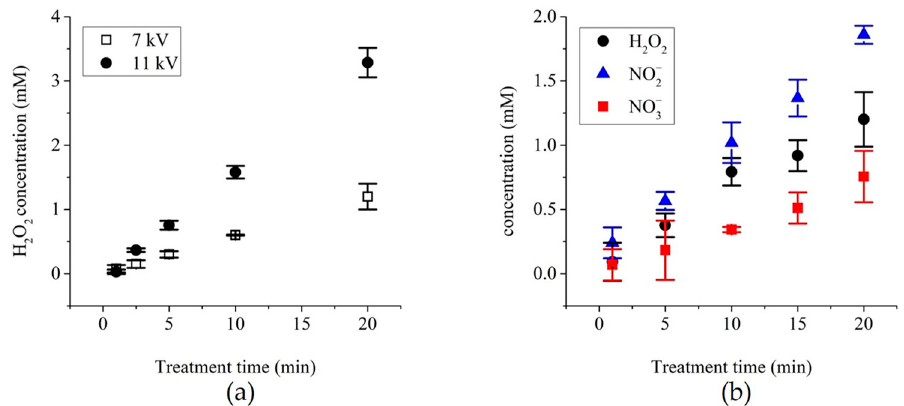
Figure 2. Chemical analysis of the plasma-treated PBS (pPBS) prepared with the NTP multi-jet source using ( a ) NTP setup 1 and ( b ) NTP setup 2. ( a ) The evolution of the concentration of H 2 O 2 in +7 kV- and +11 kV-pPBS as a function of the treatment time with the plasma, ( b ) Dosimetry of H 2 O 2 , NO 2 − , and NO 3 − levels in PBS + / + treated during 20 min. at +11 kV. Data are presented as mean values ± SD of independent duplicates (( b ): 1, 5, and 15 min.) or triplicates (all other points). Finally, the pH and the conductivity ( σ ) of the sham (PBS + exposed to only the helium flow (no plasma) and compensated for the evaporation with distilled water) and the pPBS after 20